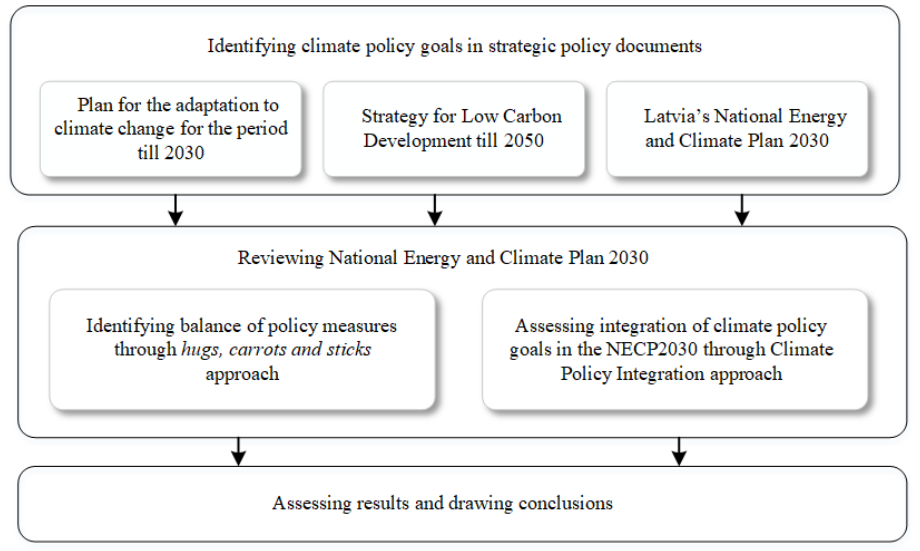
Fig. 1. Algorithm of the